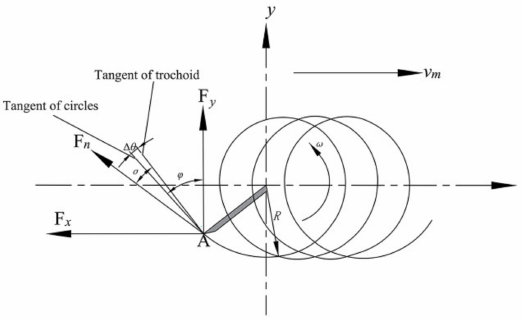
Figure 5. Schematic diagram of the force of counter-rotating blade, where Fx is the working resistance of the counter-rotating blade in the x direction, N; Fy is the working resistance of the counter-rotating blade in the y direction, N; Fn is the total resistance of the counter-rotating blade, N; ρ is rotary tillage soil cutting-specific resistance; ϕ is counter-rotating blade rotation angle, ◦ ; σ is the angle between Fn and the tangent of trochoidal, ◦ ; ∆ θ is the angle between tangent of circle and tangent of trochoidal, ◦ ; R is the motion radius of gyration, mm; and v m is machine advance speed,